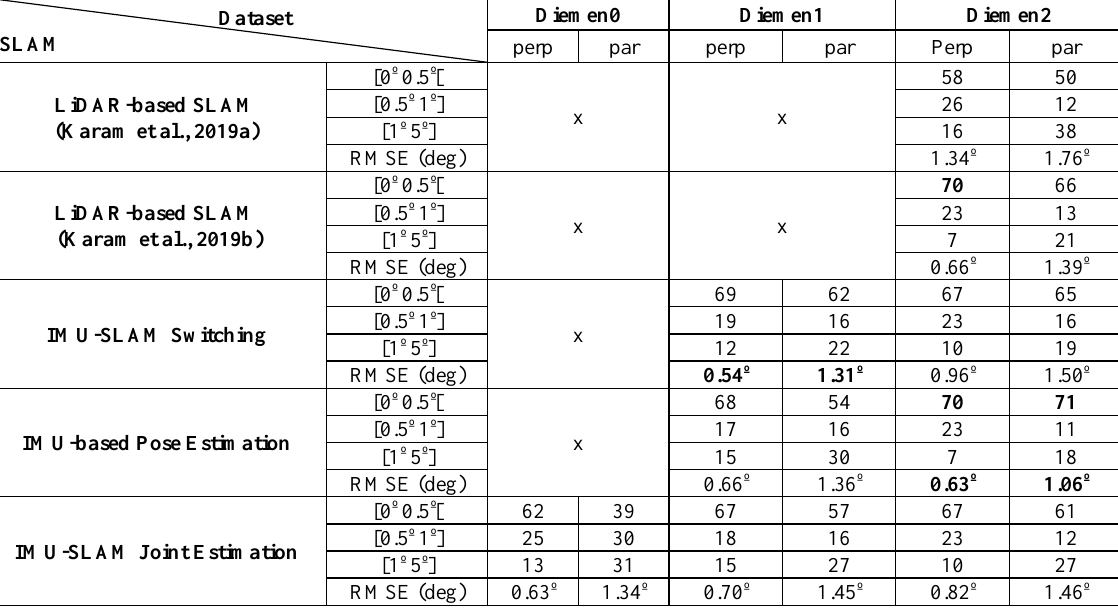
Table 4. Comparison between the performance of the proposed method on all datasets regarding the architectural constraints. The percentages of angles’ errors in three different ranges for parallelism and perpendicularity and the corresponding RMSEs. The results of two previously developed methods are also listed at the beginning of the table for comparison. The letter “x” refers to the failure of the method to process the corresponding dataset. based SLAM (black), with IMU prediction (red), IMU-SLAM switching (magenta), IMU-based Pose Estimation (blue), and the joint estimation